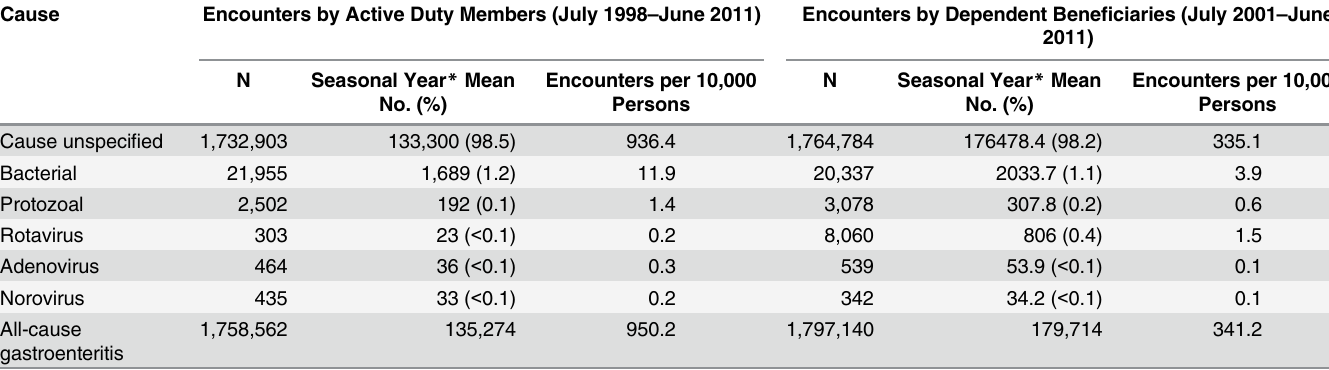
Table 2. Coded medical encounters by population and cause